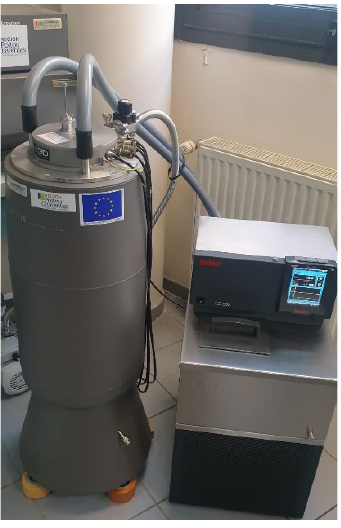
Figure 2. Image of the BT 2.15 Calvet calorimeter.